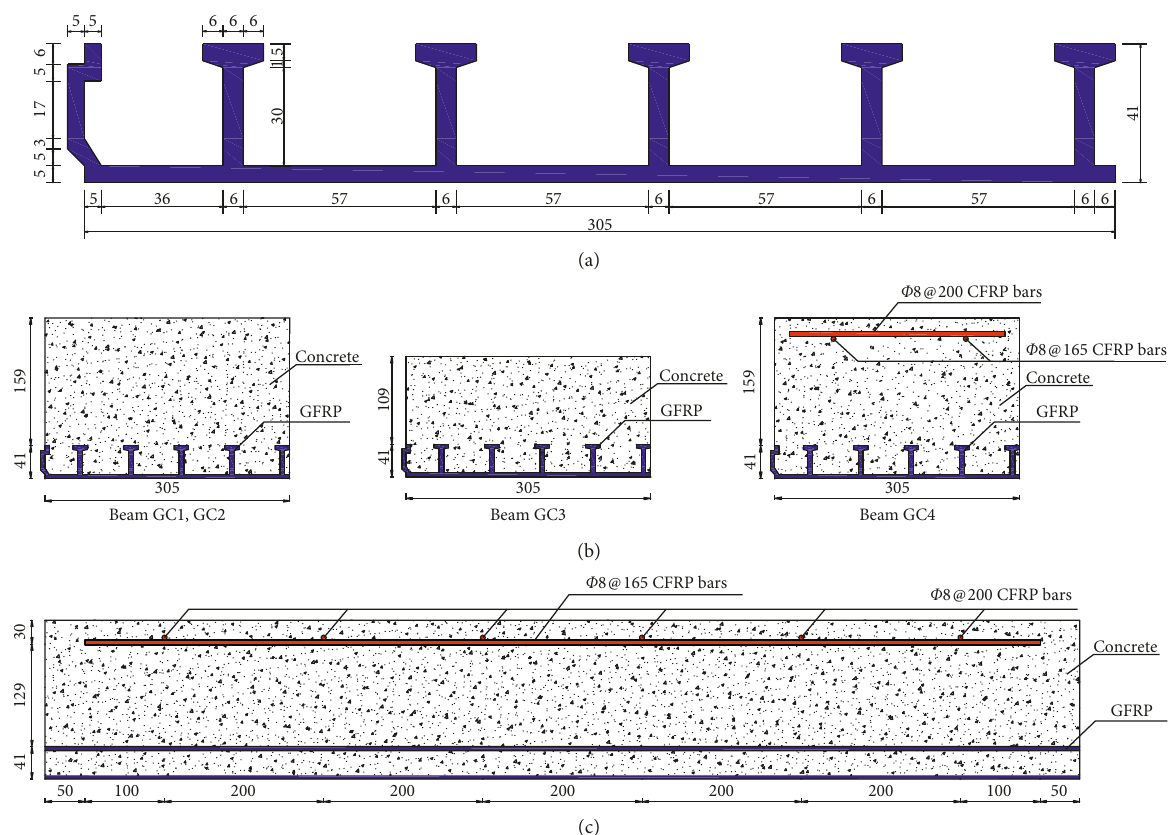
Figure 3: Design of all test specimens (mm): (a) details of the GFRP plate; (b) cross section of all test specimens; (c) elevation view of specimen GC-4.